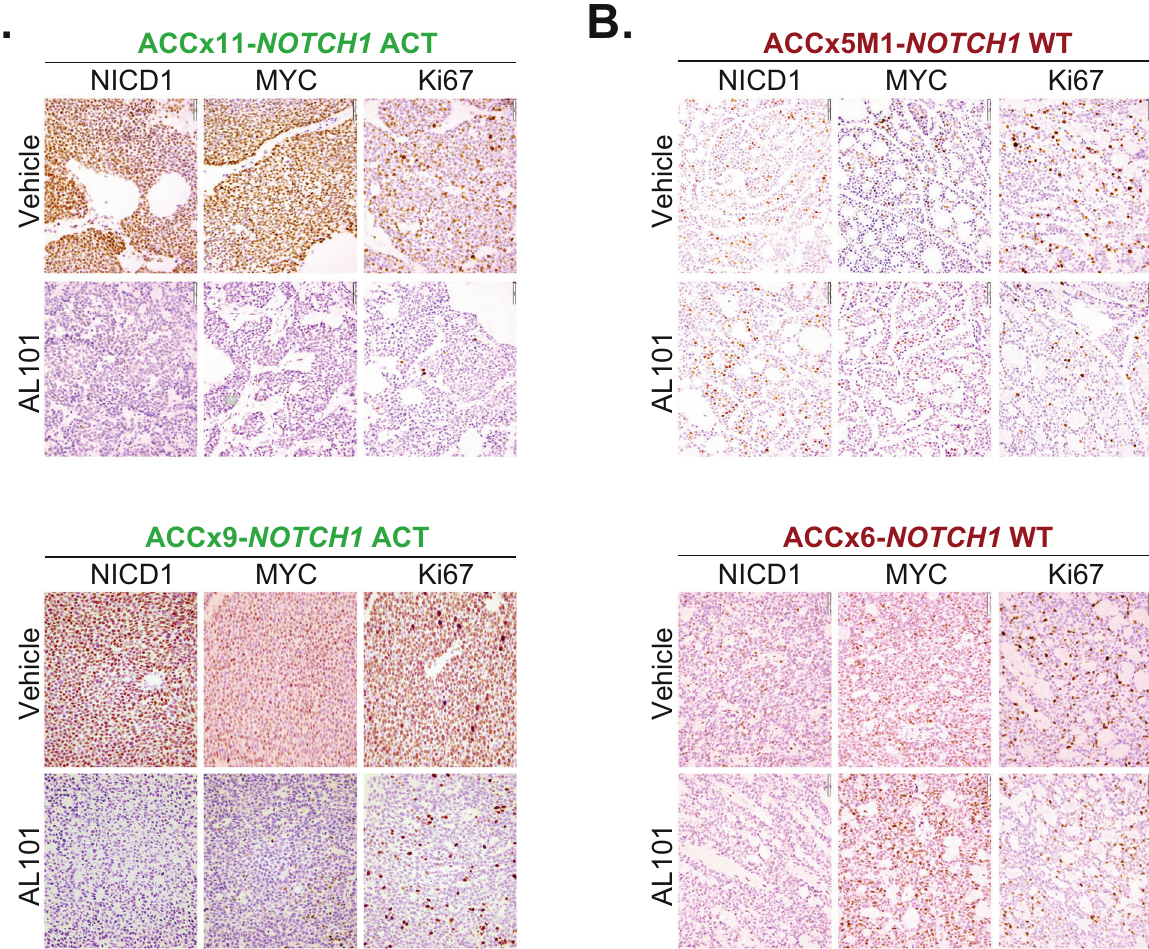
Cumulative evidence suggests that ~20% of ACC tumors carry mutations in NOTCH1 , a critical regulator of cell proliferation, differentiation, and survival [7, 8, 14, 15], and that ACCs with alterations involving portions of NOTCH1 encoding the NRR